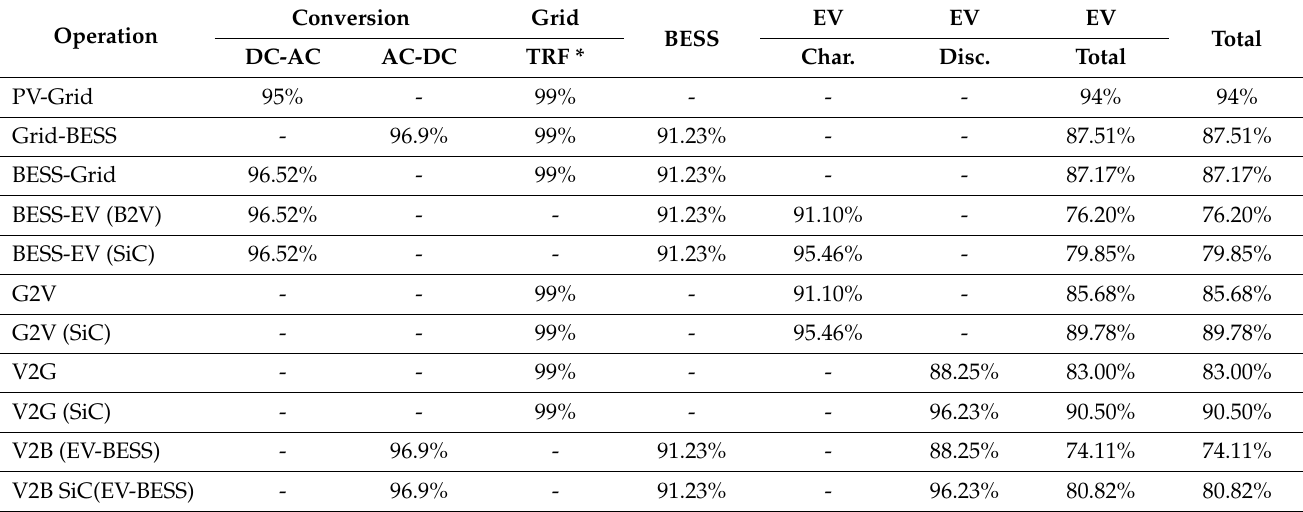
Table 7. Microgrid stage